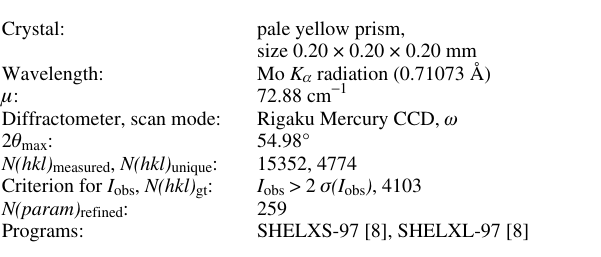
Table 1. Data collection and handling.